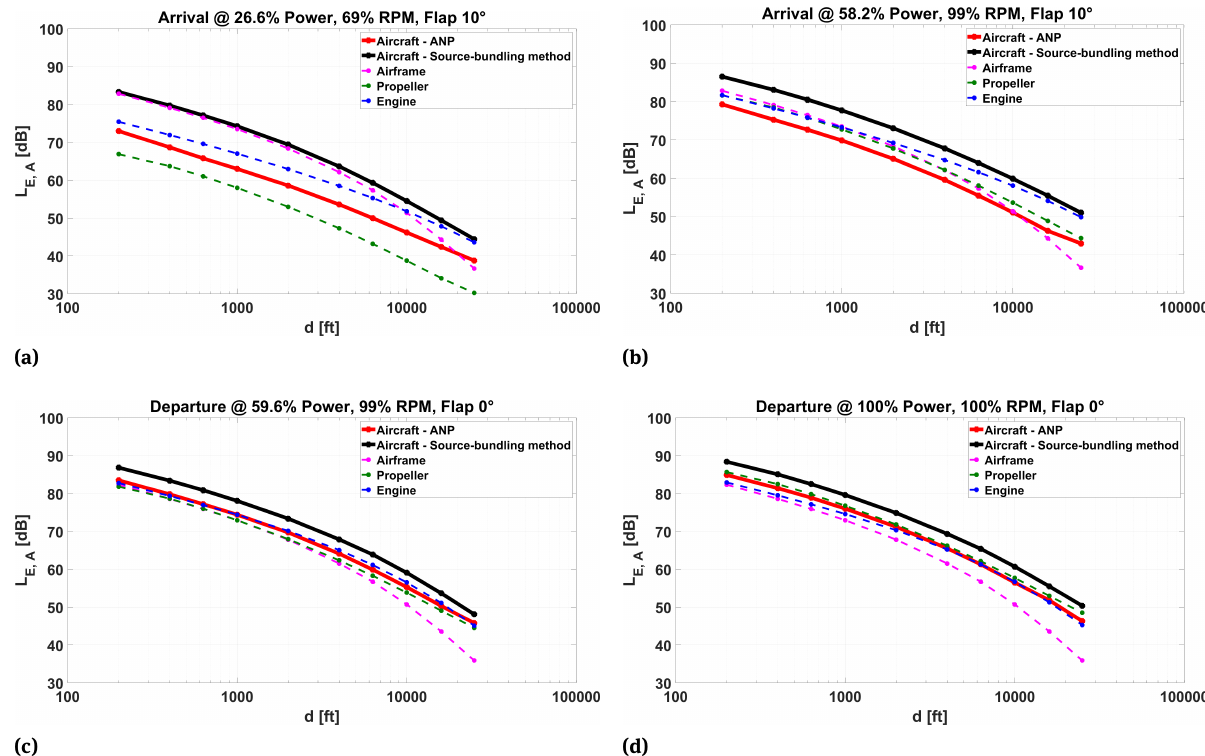
Figure 2: Comparison of SEL data from ANP database and predictions obtained from the source-bundling method for a Cessna C172R during overflight missions, for method validation. (a,b) arrival procedures. (c,d) departure